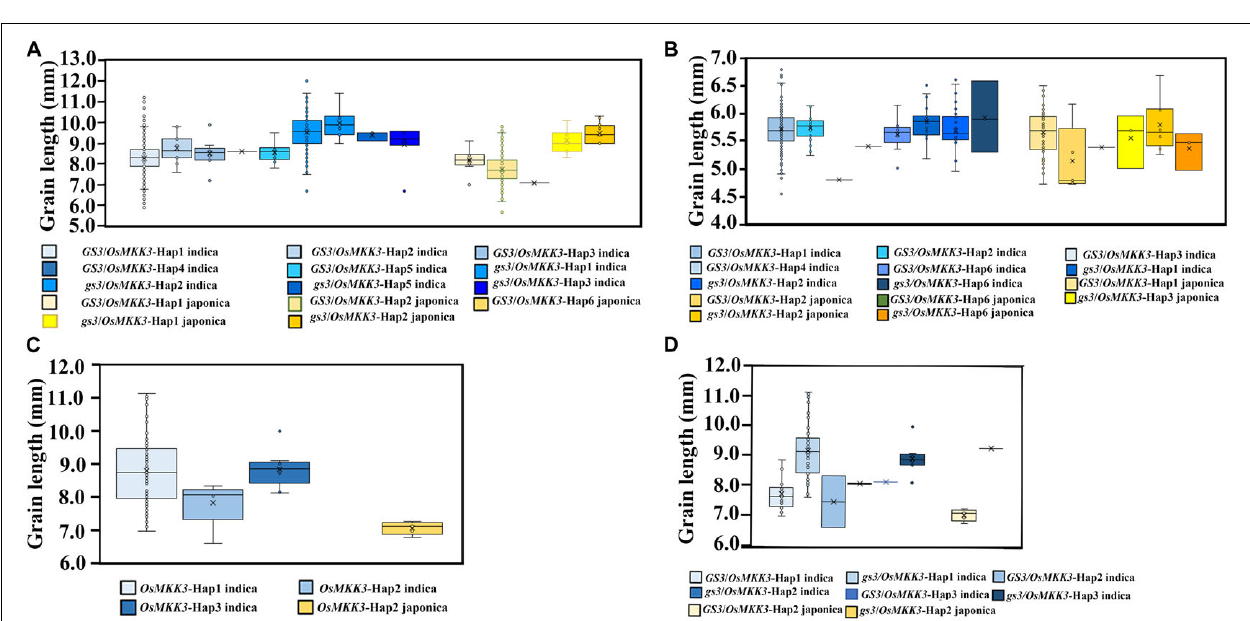
FIGURE 5 | Genetic interactions between OsMKK3 and other grain length-related genes based on diverse germplasm accessions. Box plots and kernel density plots were generated for different groups. (A) Genetic interactions between OsMKK3 and GS3 / gs3 in the rice 3K project. (B) Genetic interactions between OsMKK3 and GS3 / gs3 in Guangxi core germplasm landrace accessions. (C) Effects of OsMKK3 in improved varieties. (D) Genetic interactions between OsMKK3 and GS3 / gs3 in improved varieties.